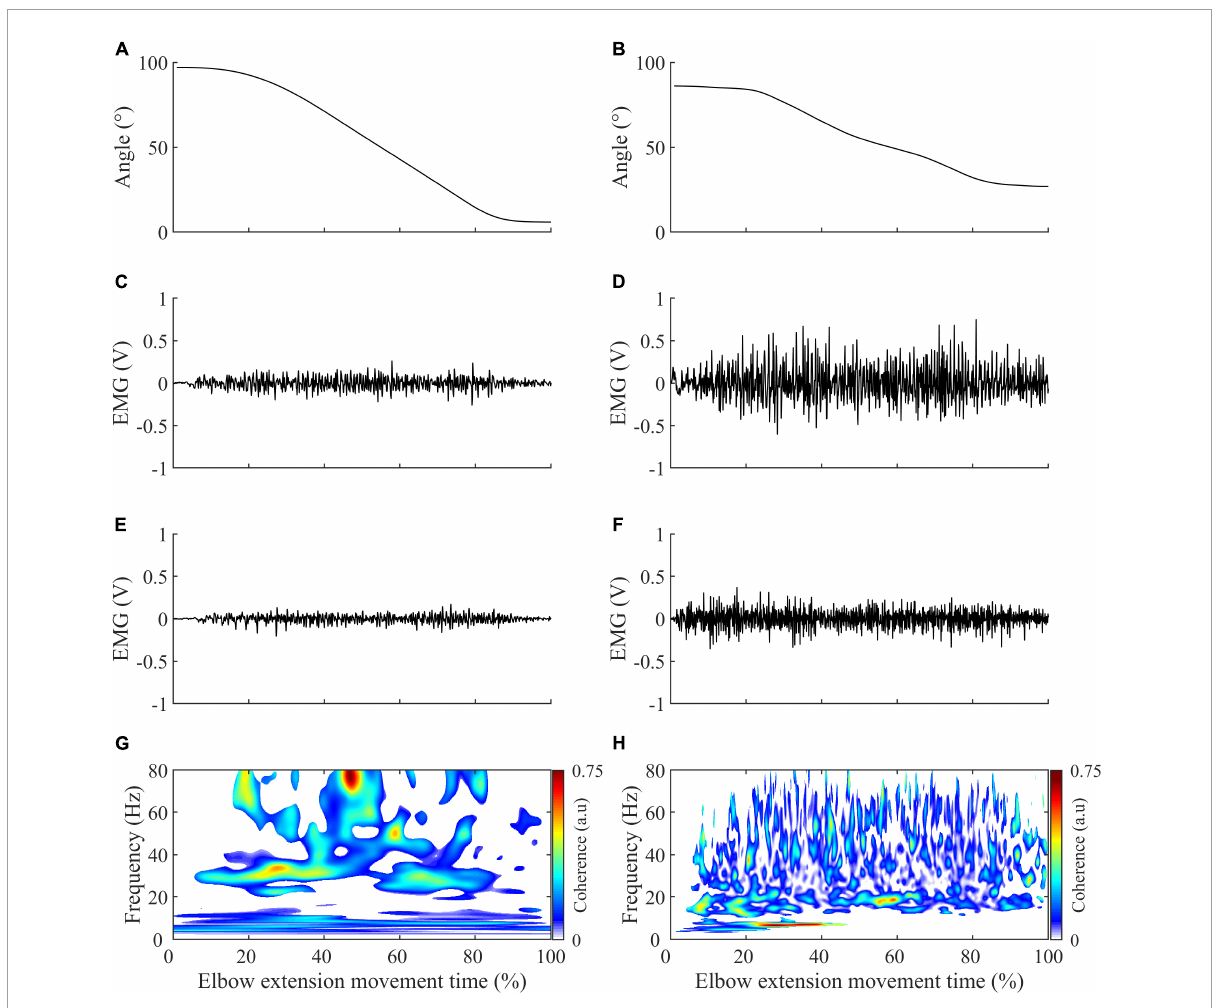
FIGURE2 Illustration of the typical recording obtained in control (left panels) and stroke subjects (right panels) during elbow extension. (A,B) Elbow range of motion variation. (C,D) Triceps brachii electromyographic activity in volt (V), with a gain setting of 1000. (E,F) Brachioradialis electromyographic activity in volt (V), with a gain setting of 1000. (G,H) Significant intermuscular coherence map calculated from the triceps brachii and brachioradialis muscle activity represented in the second and third row and according to the methodology described in